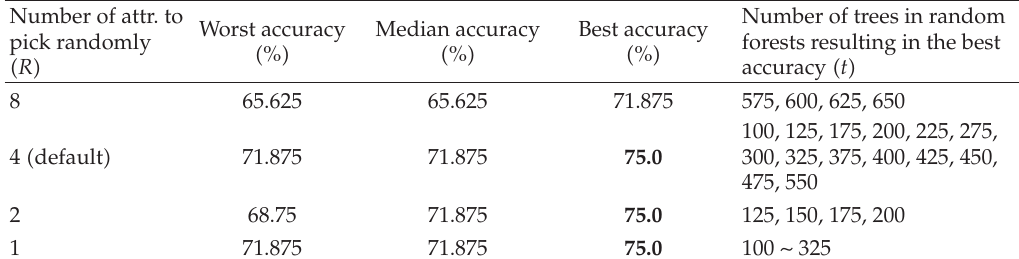
Table 14: The accuracy of random forests for the data set “lung